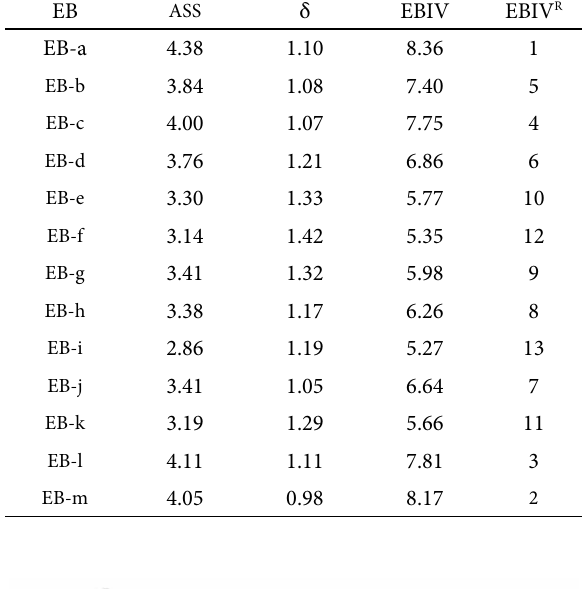
Table 4. Calculated Average Barrier Score (ABS) and Barrier- effect Index Value (EBIV) for participant responses to barriers of implementing EMS in the Nigerian construction industry